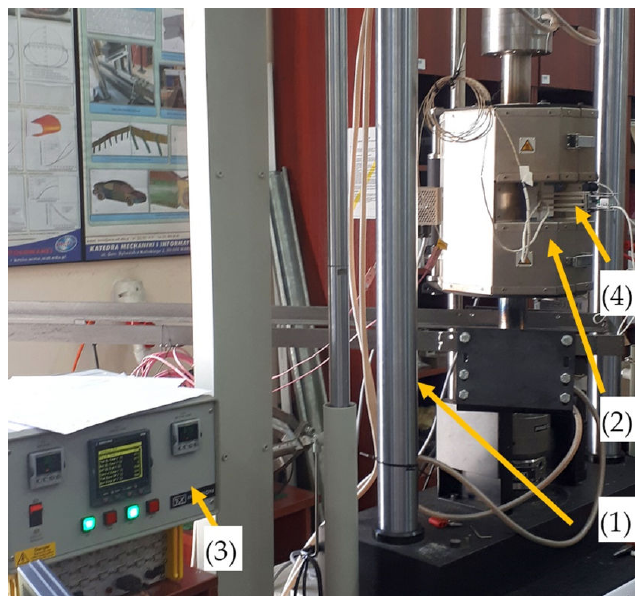
Figure 3. Testing stand: (1) Instron 8862 testing machine, (2) high-temperature furnace, (3) Eurotherm 2704 controller, and (4) Epsilon 3448 linear extensometer.